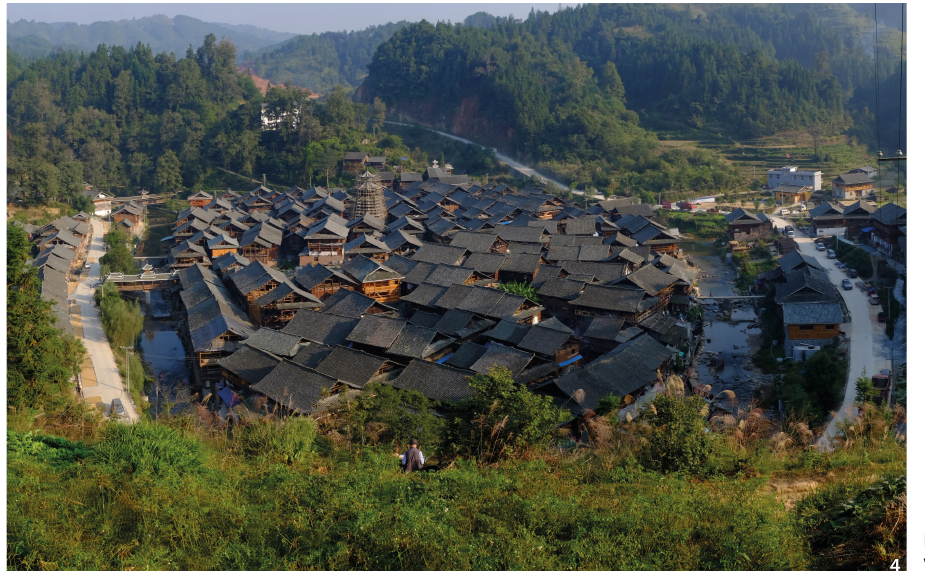
Figure 4 Bird view of Zengchong Village (Source: Peng Zhang).